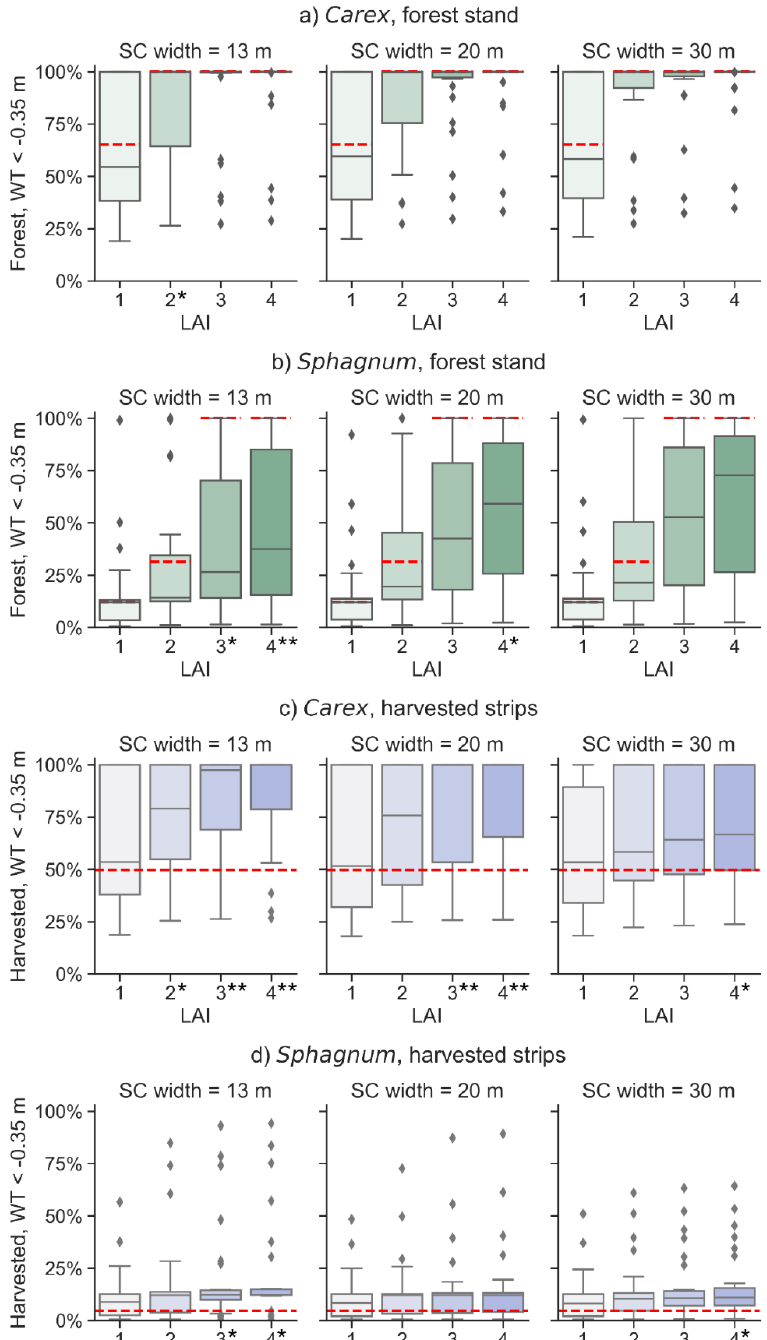
Figure 7. The simulated share of well-drained areas (WT < − 0.35 m during July–August) with Carex peat ( a , c ) and Sphagnum peat ( b , d ) for unharvested forest stands ( a , b ) and harvested (treeless) strips ( c , d ). In ( c , d ), the LAI indicate the LAI of the surrounding forest area. The box plots represent between-year variations over 30 years. The dashed, red lines indicate the median for the stands with no harvesting ( a , b ) or the median for the clear-cut ( c , d ). The ditch depth was − 0.6 m in all simulations. SC width refers to the width of the harvested strip. For tree stand layouts, see Figure 2. In all cases, the shortest distance between ditches was 40 m. For forest stands ( a , b ), statistically significant differences (* p -value < 0.05; ** p -value < 0.01) were noted comparing the strip cut stands to the stands with no harvesting. For harvested strips, statistically significant differences were noted compared to